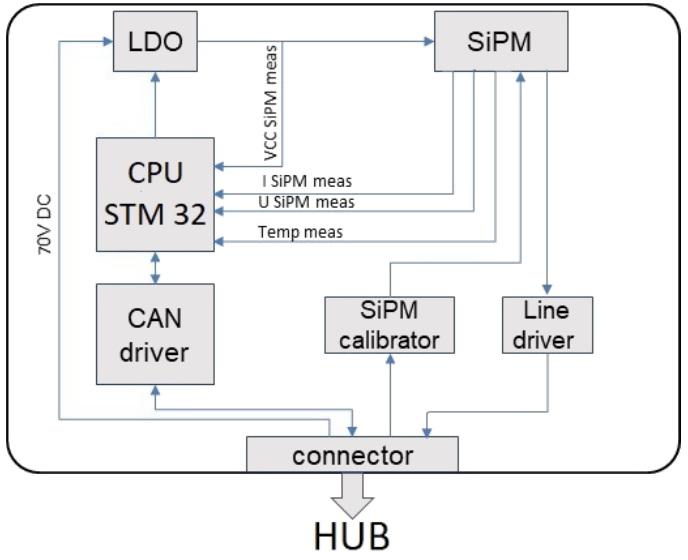
Figure 6. MCORD AFE